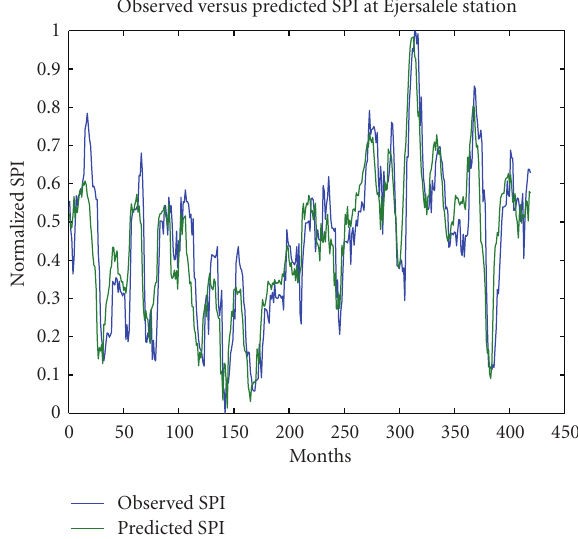
Figure 4: SPI 12 forecast results for the best WA-ANN model at the Ejersalele station (1-month lead